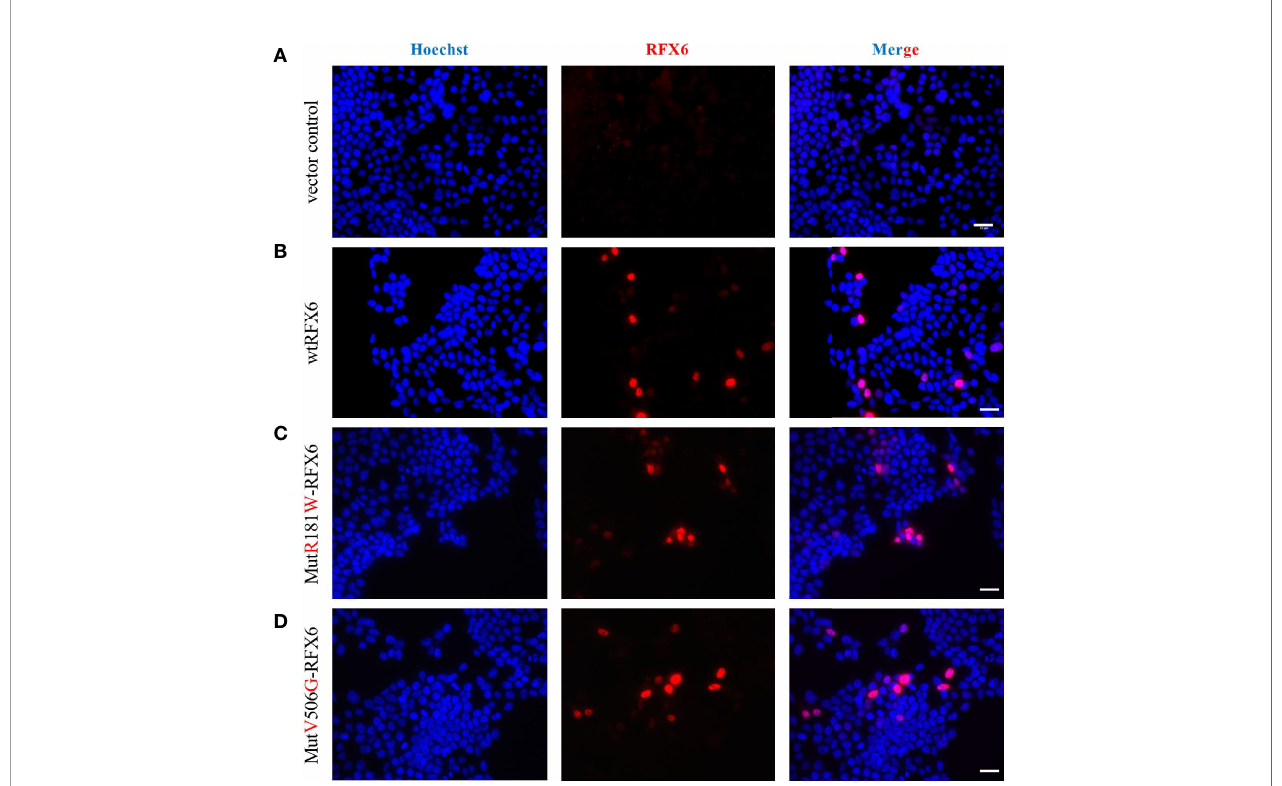
FIGURE 7 | Expression and localization of of wtRFX6 or MutR181W-RFX6 or MutV506G-RFX6 in HEK293. HEK293 cells were transiently transfected with pRIG- empty or pRIG-wtRFX6 or pRIG-MutR181W or pRIGMutV506G -R FX6 constructs and immunostained for RFX6 post 48 h of transfection. Scale bar 25 m m. Legend: (A) Vector control, (B) wtRFX6, (C) Mut R181W-RFX6, (D)